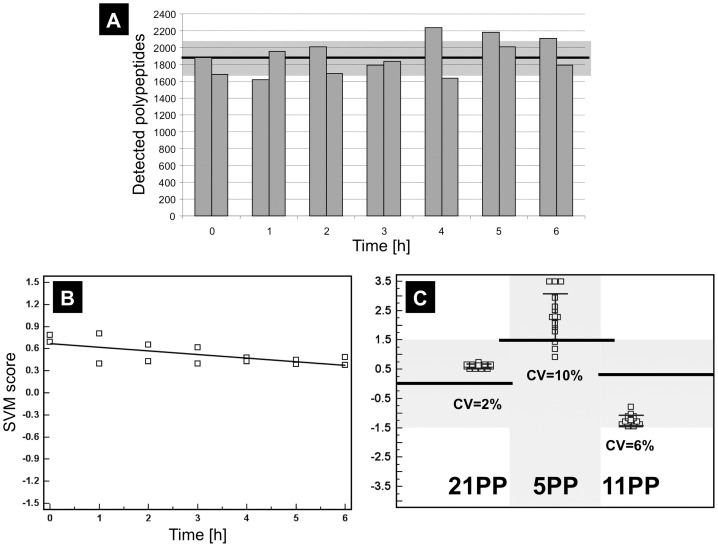
Assessment of biomarker stability and reproducibility.(A) An average of 1887±202 polypeptides was detected in each of the 14 measurements stored for different times at RT. The mean is marked with a bold line; standard deviation is highlighted in grey. (B) Beyond this qualitative assessment biomarker signatures were applied to the 14 stability replicates to obtain quantitative data of time-dependent stability of seminal plasma. For 21PP ranked correlation analysis revealed a significant decrease of SVM scores over time with Spearman’s rho of –0.576 (95% CI –0.854 to –0.07, P = 0.0379). Regression analysis unveiled a decrease rate of –0.05 a.u. (<2%) per hour. 5PP and 11PP displayed no significant time dependency. (C) Analytical precision of the established SVM classifiers was assessed by applying it to 15 CE-MS data sets obtained from independent replicates of a sample of a 57 years old patient with significant BPH. Mean classification scores were 0.619±0.07, 2.290±0.81, and -1.239±0.18 for 21PP, 5PP, and 11PP respectively. Coefficients of variations were calculated by dividing standard deviations by the observed overall range of SVM scores [highlighted in grey, 21PP from –1.50 to +1.50 (3.0 a.u.), 5PP from 4.50 to +3.0 (7.5 a.u.), and 11PP from –1.50 to +1.50 (3.0 a.u.)]. Coefficients of variations were 2.2%, 10.8%, and 6.1%, respectively. Classification cut offs are represented by horizontal lines. The boxes depict means and standard deviation as whiskers.